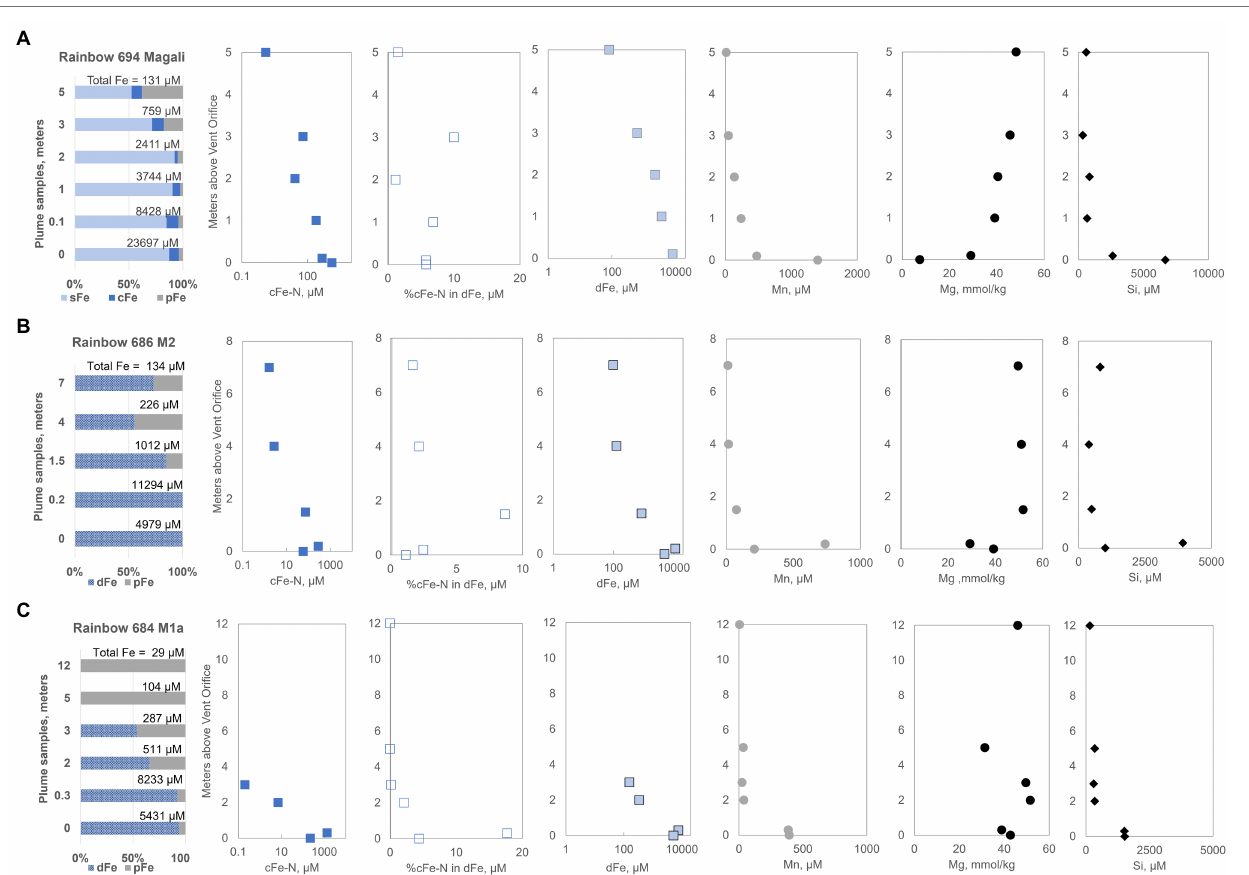
FIGURE 3 | Iron size fractionation data for Rainbow vent fluids (A) Magali, (B) Fumeur Nouveau (M2), and (C) Fumeur Tres Dense (M1a) are presented along with profiles containing distance from the orifice vs. measured different chemical species (e.g., cFe-N, dFe, Mn, Mg, and Si). sFe, soluble iron; cFe, colloidal iron; pFe, particulate iron; cFe-N, nanoparticle iron; dFe, dissolved